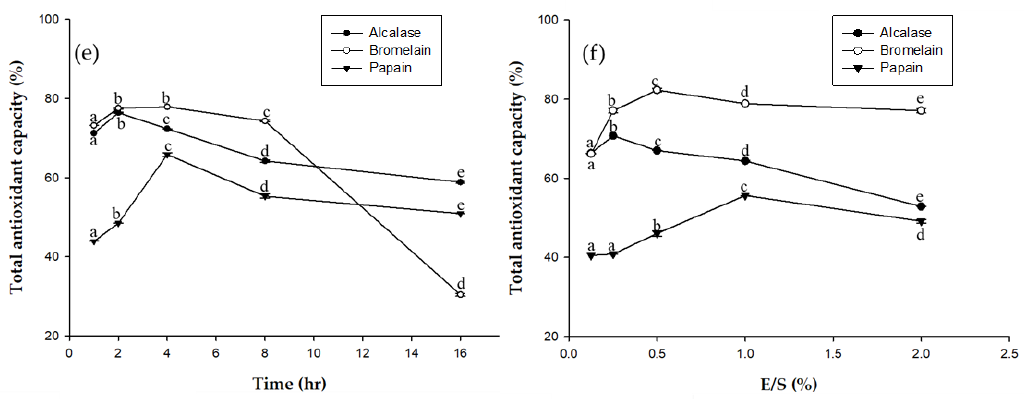
Figure 2. Antioxidant effect of the three EPHs (alcalase, bromelain, and papain) using three 178 assays: ( a ) Antioxidant e ff ect at di ff erent times based on DPPH free radical scavenging assay; ( b ) antioxidant assays: ( a ) Antioxidant effect at different times based on DPPH free radical scavenging 179 Antioxidant e ff ect at di ff erent enzyme concentrations based on DPPH free radical scavenging assay; ( c ) assay; ( b ) Antioxidant effect at different enzyme concentrations based on DPPH free radical 180 Antioxidant e ff ect at di ff erent times based on reducing power assay; ( d ) Antioxidant e ff ect at di ff erent scavenging assay; ( c ) Antioxidant effect at different times based on reducing power assay; ( d ) 181 enzyme concentrations based on reducing power assay; ( e ) Antioxidant e ff ect at di ff erent time based Antioxidant effect at different enzyme concentrations based on reducing power assay; ( e ) 182 on ABTS total antioxidant capacity; ( f ) Antioxidant e ff ect at di ff erent enzyme concentrations based on Antioxidant effect at different time based on ABTS total antioxidant capacity; ( f ) Antioxidant effect at 183 ABTS total antioxidant capacity. Means in the same form with various characters denote significant different enzyme concentrations based on ABTS total antioxidant capacity. Means in the same form 184 di ff erences ( p < 0.05). Data are expressed as mean ± SD from triplicate determinations. with various characters denote significant differences ( p ˂ 0.05). Data are expressed as mean±SD from 185 triplicate determinations. 186